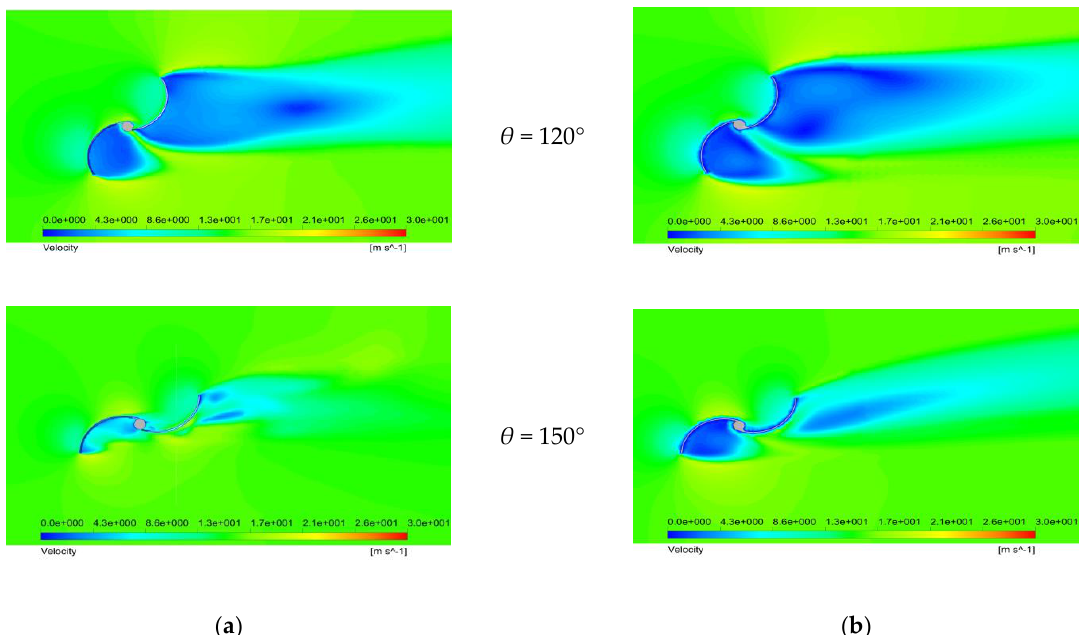
Figure 18. Air flow velocity distributions at an air velocity of 15.8 m/s around ( a ) the IceWind turbine and ( b ) the Savonius wind turbine.